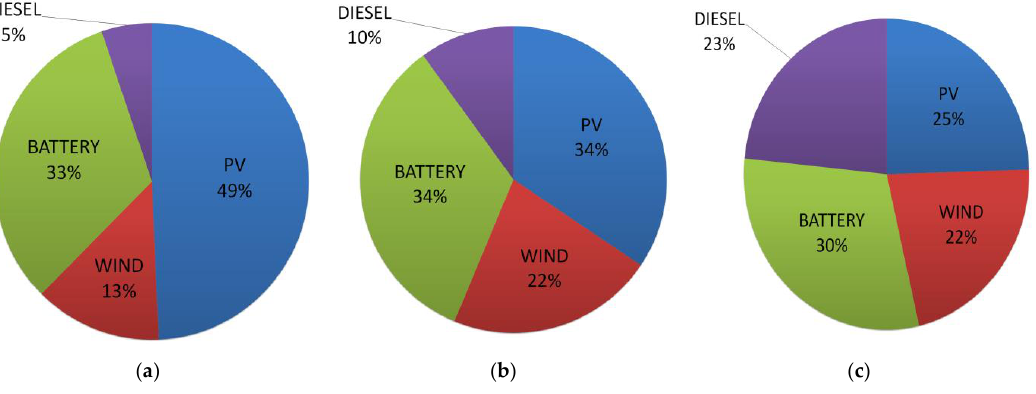
Figure 16. The annual contribution of energy generation by PV/WT/battery and DG for MOALO. ( a ) Solution #1; ( b ) solution #10; ( c ) solution #20.